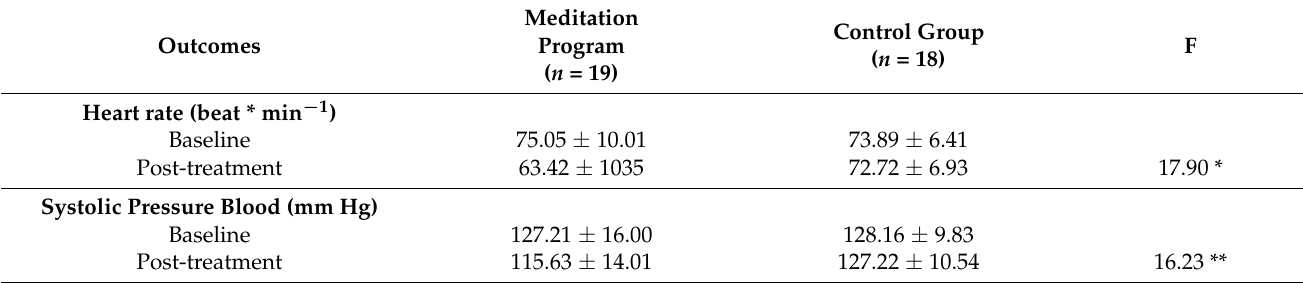
Table 2. Comparison of outcomes between before and after